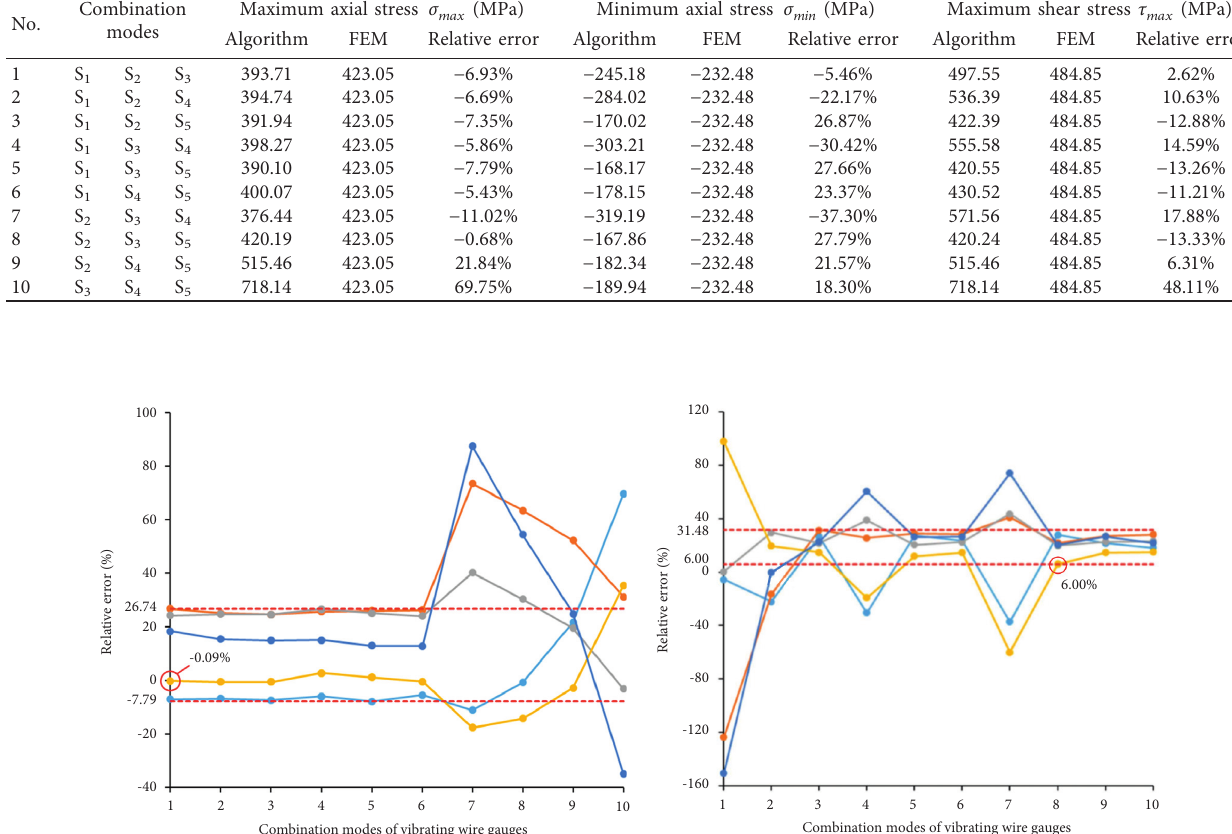
; (b) minimum axial stress σ max